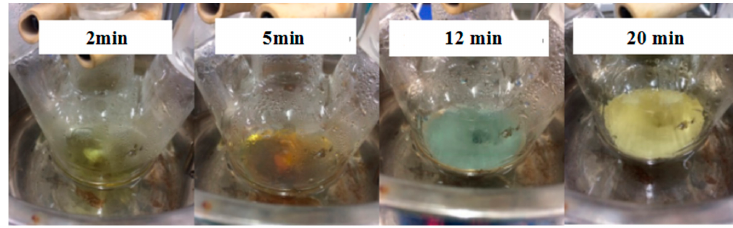
Figure 3. The color change during the preparation of Ag nanoparticles.